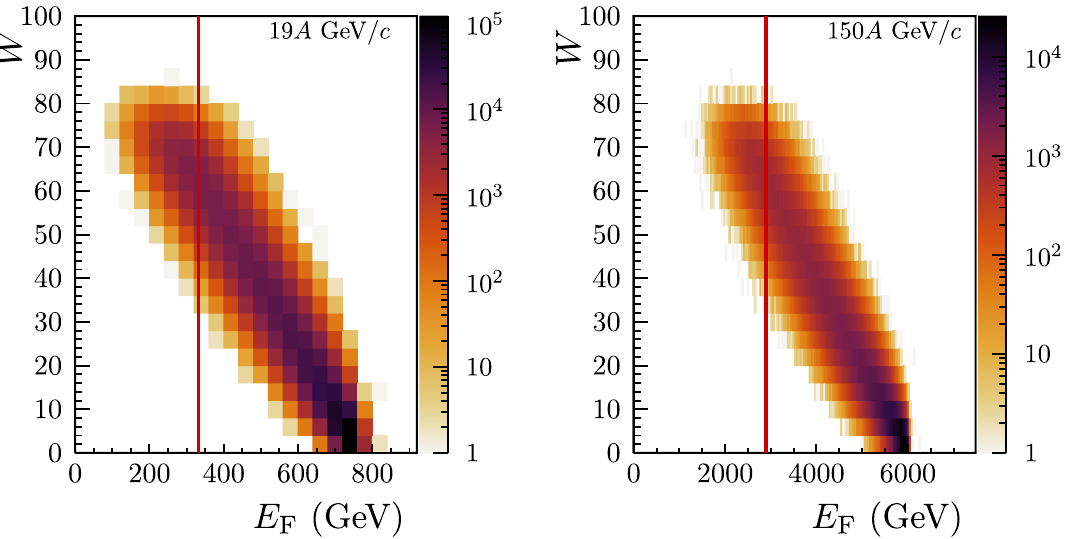
Fig. 4 Distributions of W versus E F for all inelastic collisions at 19 A ( left ) and 150 A GeV / c ( right ) beam momenta calculated from the Epos1.99 model. The vertical red lines show the value of the cut on E F for selecting the 5% most central collisions